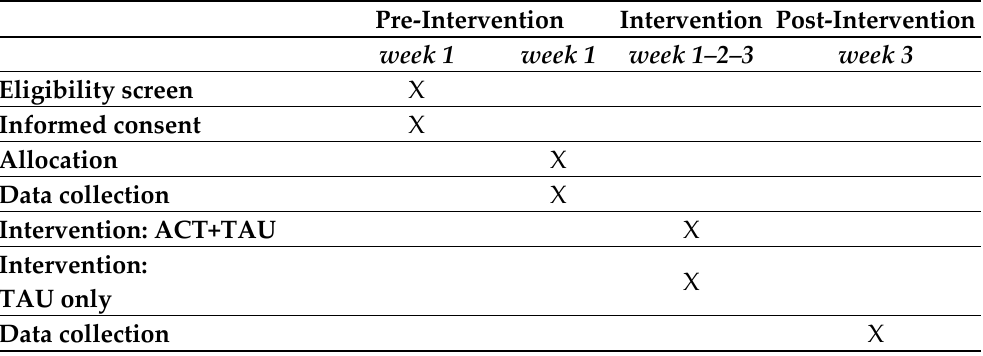
Figure 1. Schedule of enrollment, assessment, and intervention.